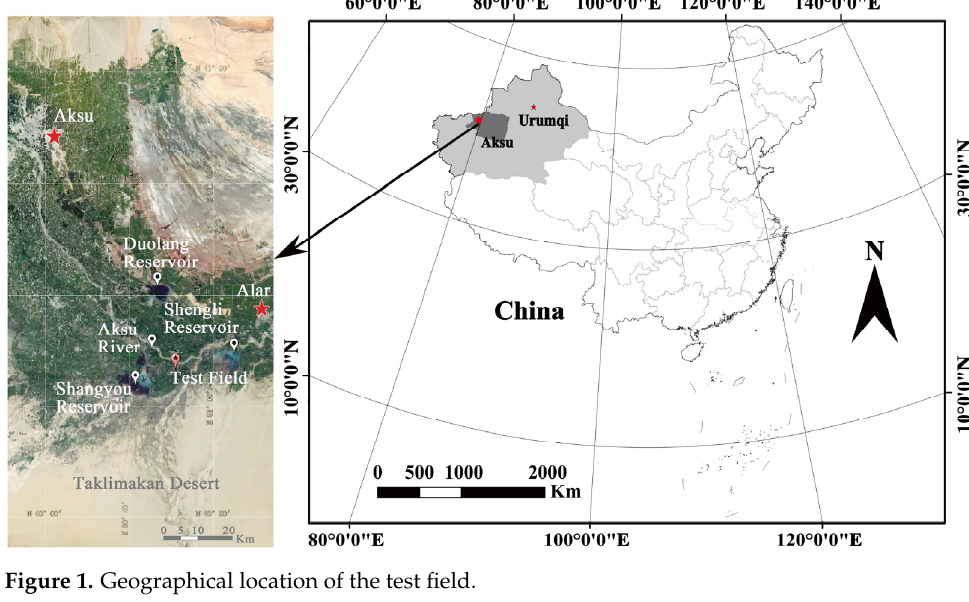
Figure 1. Geographical location of the test field. Table 1. Soil physical properties of the experimental field.